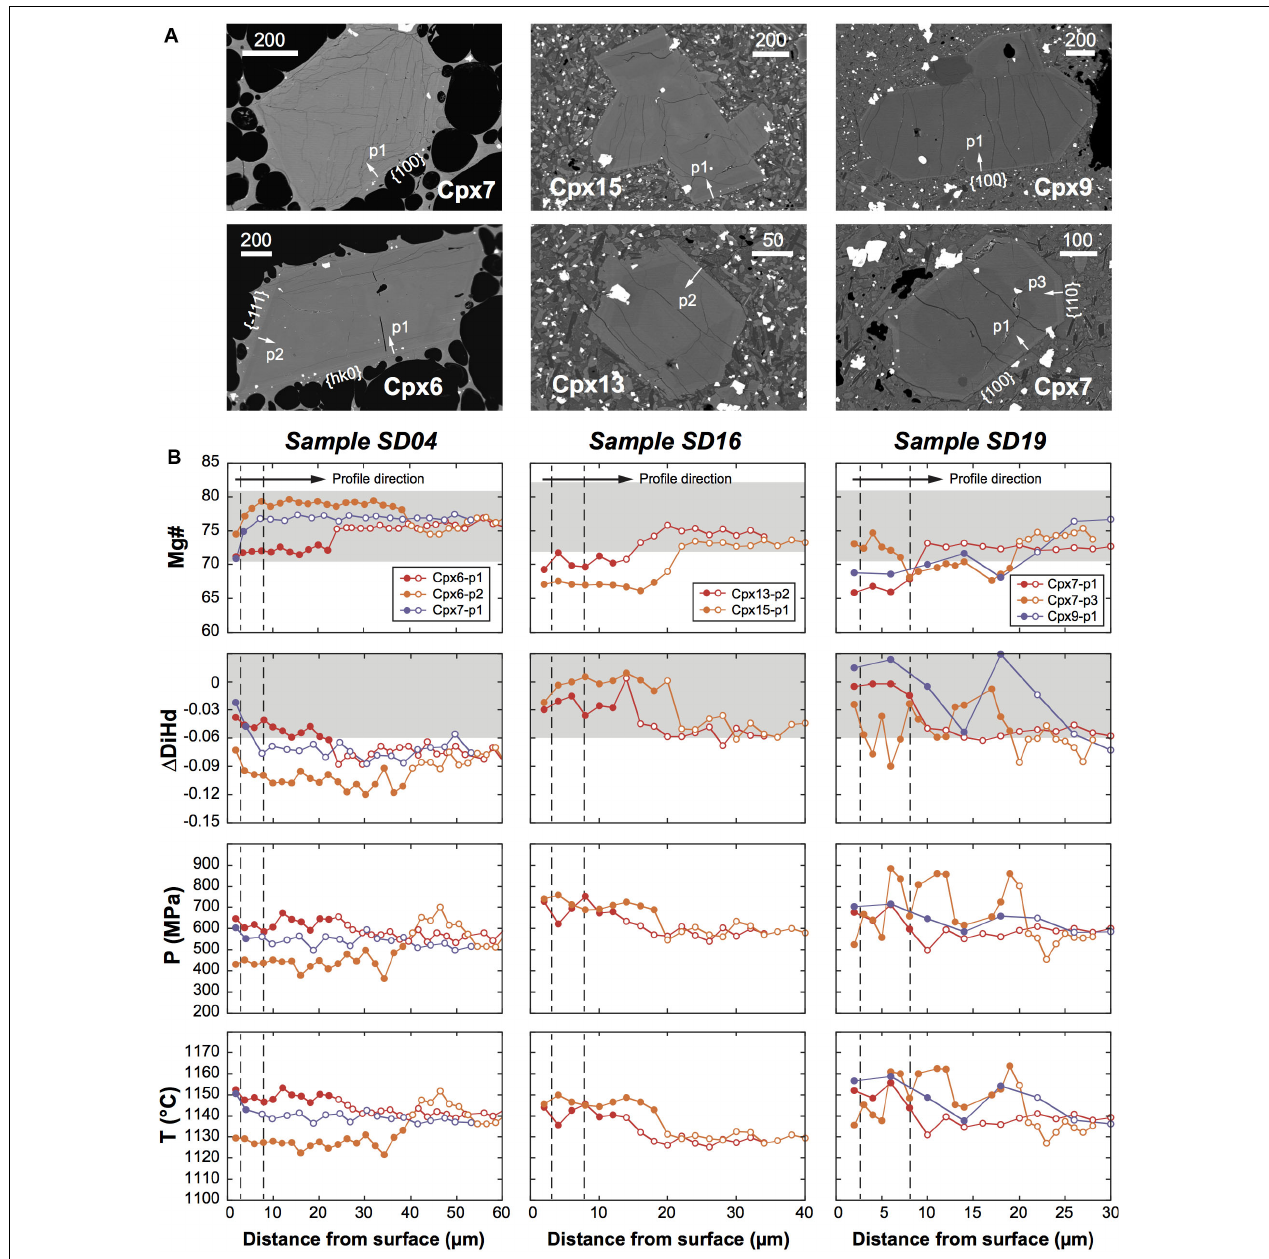
FIGURE 7 | (A) BSE images of zoned clinopyroxene phenocrysts from three samples, indicating the locations of compositional traverses. The outer rim zones are well recognized. See Figure 2 for microphotographs of some of the crystals. (B) Profiles across the clinopyroxene rims indicated above. Shown are clinopyroxene Mg#, (cid:49) DiHd calculated after Mollo et al. (2013), and pressures and temperatures after Putirka et al. (2003); all calculated values use the host groundmass composition. Filled symbols mark points located within the rim zones. Dashed lines delimit the range of 3–8 µ m distance to the crystal surface, where most rim analyses for thermobarometry were carried out. Gray shading marks the equilibrium range used for the K D (Fe-Mg) cpx − liq and (cid:49) DiHd filter